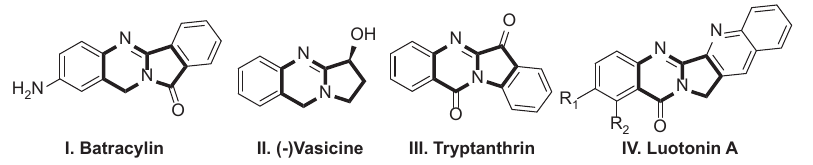
Figure 1 Biologically active isoindoloquinazolines and their